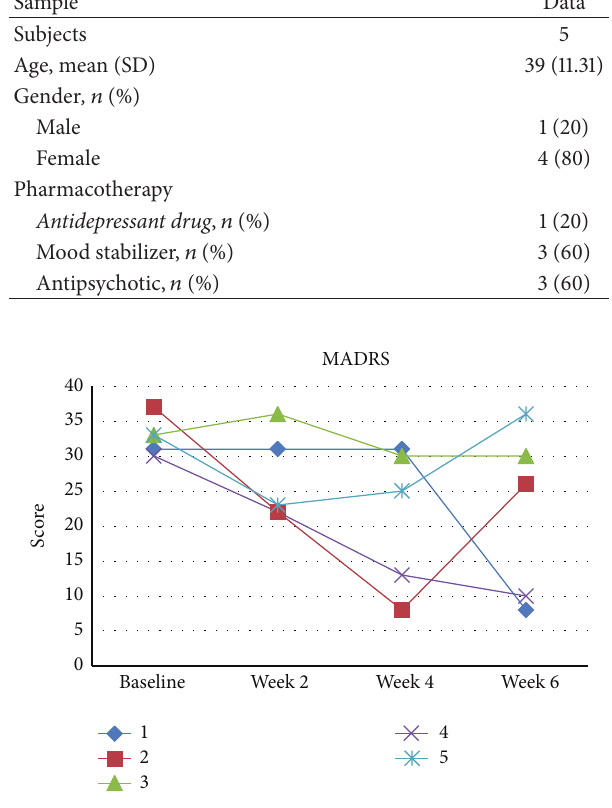
Figure 1: MADRS scores for each patient (pilot